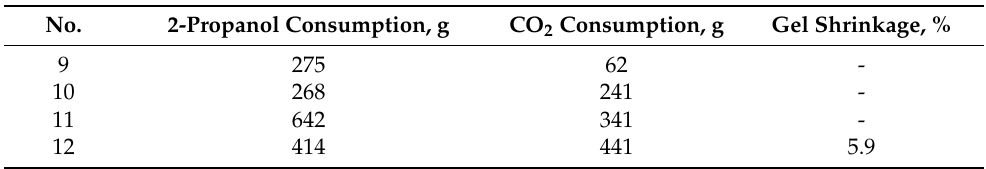
Table 4. Consumption of components and gel shrinkage during the solvent exchange process through homogeneous region.